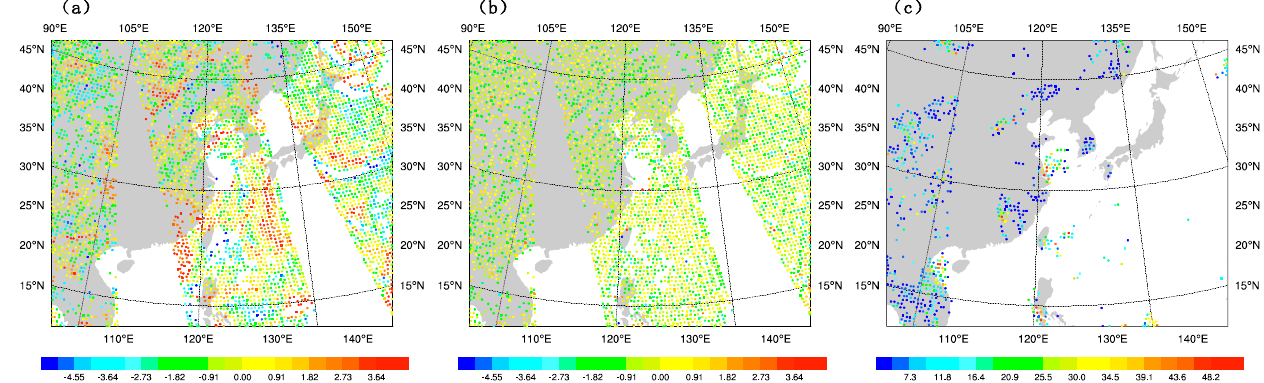
Figure 4. ( a ) The OMB (unit: K), ( b ) the OMA (unit: K), and ( c ) the SI index (value > 5 K) at 0600 UTC on 22 July 2018.